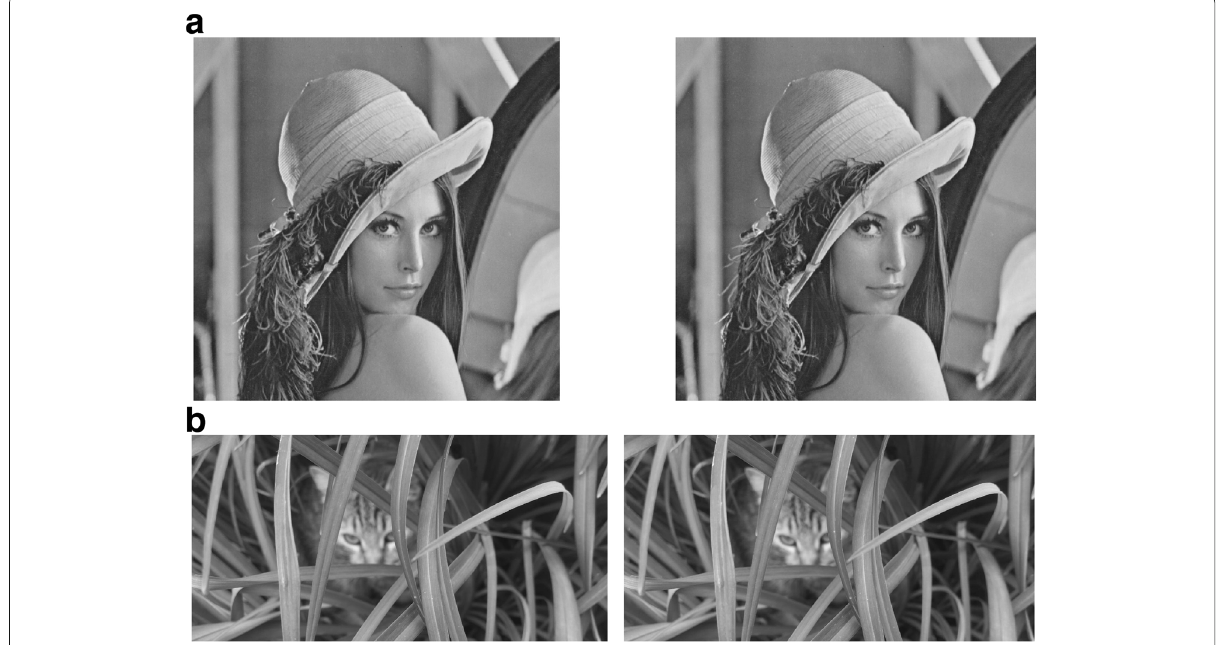
Fig. 5 Embedding 64 bits in the DWT domain. a N = 64, PSNR = 54.84 dB. b N = 312, PSNR = 62.94